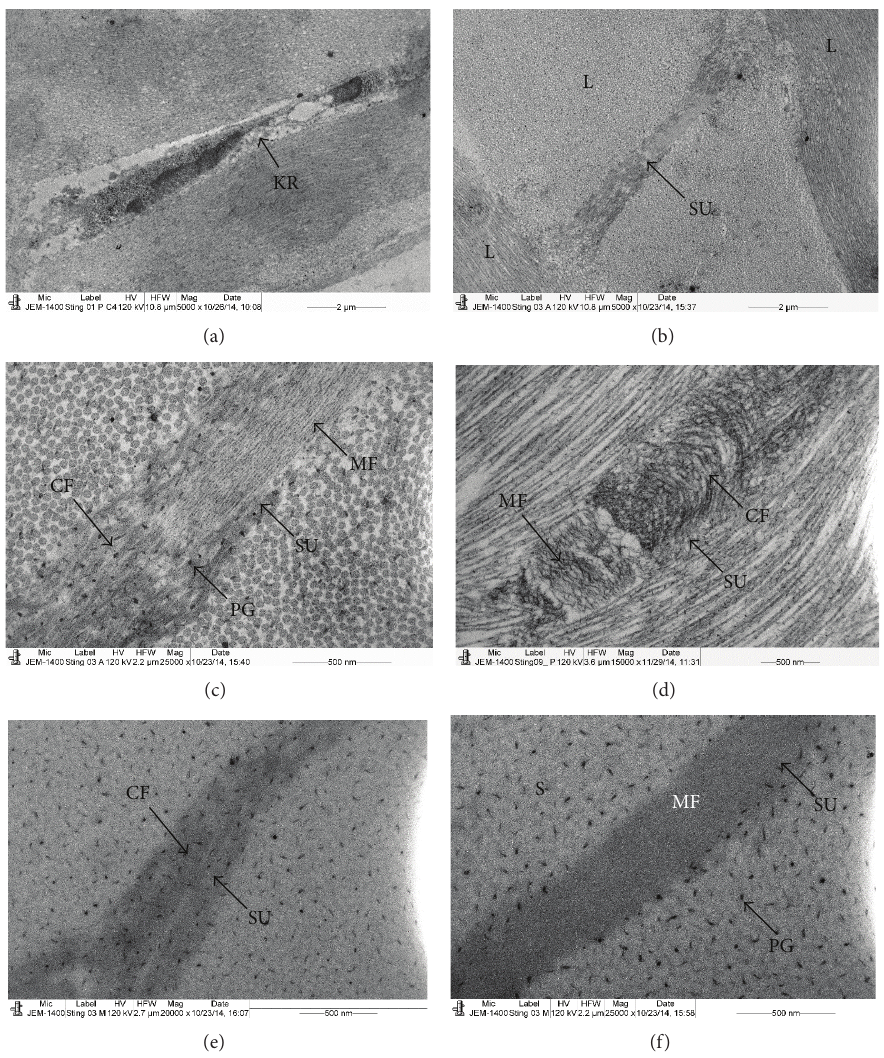
Figure 3: Electron micrograph of stingray fish cornea; (a) part of the stroma showing the keratocyte containing large nucleus; (b) a single suture running obliquely between two lamellae; (c) the middle part of the suture showing presence of CFs and microfibrils. The microfibrils lacked the PGs whereas CFs were decorated with PGs. (d) Sagittal section of a suture showing the CFs surrounding the microfibrils; (e) part of the suture showing presence of PGs on the CFs of the suture; (f) part of suture showing absence of PGs on the microfibrils of suture. CF: collagen fibrils, DM: Descemet’s membrane, L: lamellae, KR: keratocyte, MF: microfibrils, PG: proteoglycans, and SU: suture.